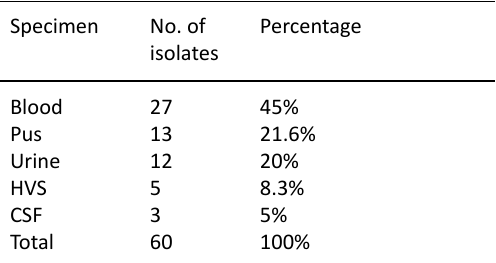
Table 3. Specimen wise distribution of Coagulase Negative Staphylococcus isolates (n=60) Specimen